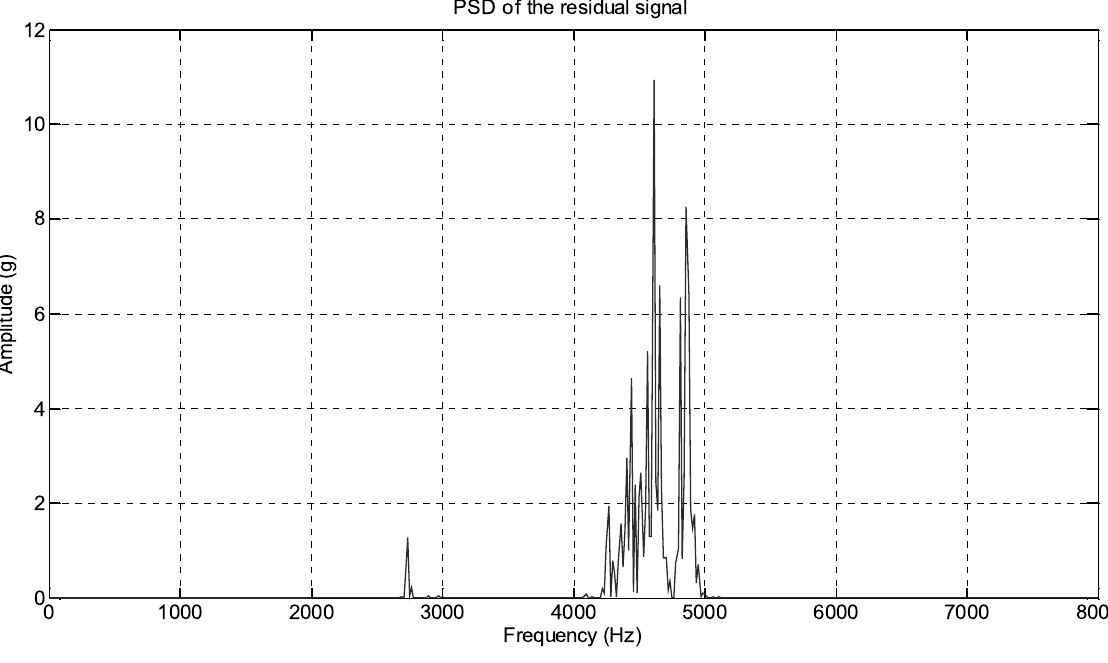
Fig. 12. Residual signal in the frequency domain.